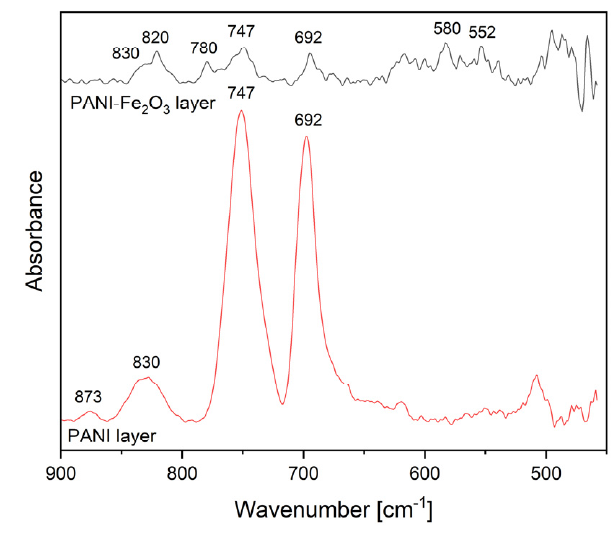
Figure 6. FTIR spectra of PANI (the red line) and PANI-IO (the black line) layers. In the spectral range of 1000–450 cm − 1 , we saw the major vibration modes that are characteristic to the polymerization process of PANI, namely, the ortho, meta, and para substitutions in benzene rings [1,35]. The ratio between the intensities of 747 (or- tho substitutions, 1,2 disubstitutions in benzene ring) and 692 cm − 1 (meta substitutions, 1,3 disubstitutions in benzene ring) was similar in both FTIR spectra from Figure 6. The 873 cm − 1 IR band was due to meta substitutions in benzene rings [1,35]. The para substitutions in benzene rings manifest vibrations in the 860–800 cm − 1 spectral range and represent a measure of the conductivity of PANI layers [1]. The band from 830 cm − 1 assigned to para substitutions (in the FTIR spectrum of the PANI layer) appeared in the FTIR spectrum of the PANI-IO layer as a shoulder on the 820 cm − 1 IR band, which can also be attributed to para substitutions [35]. Therefore, the diminishing of the intensity of the IR band specific to para substitutions at 830 cm − 1 and the appearance of the IR band at 820 cm − 1 denoted that the presence of iron oxide in the polymer structure affected its conductivity. The IR band at 780 cm − 1 that appeared only in the FTIR spectrum of the PANI-IO layer was assigned to C-H out-of-plane bending vibrations of a phenyl ring [1,35]. The presence of the IR bands between 820 and 780 cm − 1 in the spectrum of the PANI-IO layer signified that the simultaneous deposition of aniline and the Fe 2 O 3 solution in plasma influenced the coupling between the phenyl nuclei and amino groups during the polymerization process of polyaniline. XPS studies were used for the characterization of iron oxide (PANI-IO)-doped polyani- line coatings. XPS spectra were registered to determine the phase and composition of the PANI-IO nanoparticles. The XPS general spectrum of PANI-IO (Figure 7a) revealed the presence of O 1s, N 1s, C 1s, and Fe 2p. The elements such as carbon and nitrogen belonged to polyaniline, while the element iron belonged to the iron oxide used as a dopant. Figure 7b,c show the deconvoluted N 1s and Fe 2p XPS spectra of PANI-IO thin films. The N 1s XPS core-level spectrum of PANI-IO (Figure 7b) was deconvoluted into three peaks in agreement with previous research [36]. The three peaks were centered at 398.6, 400.2, and 402.0 eV. The peak located at 398.6 eV was attributed to imine nitrogen (=N-), which was in good accordance with preceding studies [37]. According to former studies [38], the presence of an imine peak observed in the deconvoluted N 1s spectrum indicates incom- plete protonation. The presence of a peak located at around 400.2 eV revealed the presence of a radical cation (-N • + H-) [39]. The peak located at around 402.0 eV was attributed to generated iminium ions (-N +